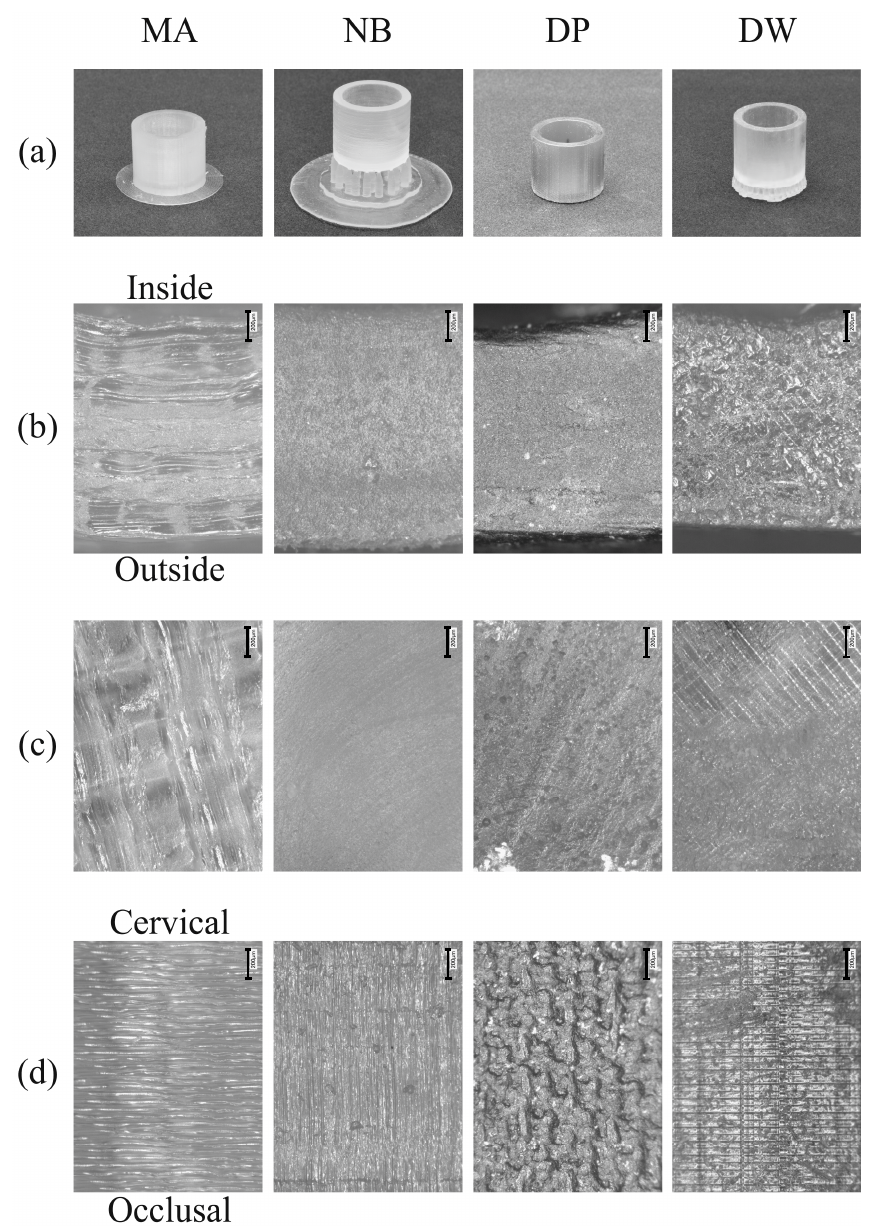
Figure 2. Images of the crowns fabricated using 3D printers (200 × magnification, “I” presents 200 µ m). ( a ) Exterior view; ( b ) basal plane of the cervical part; ( c ) inner upper surface; ( d ) outer sidewall of the patterns. The scale bar is 200 μ m.